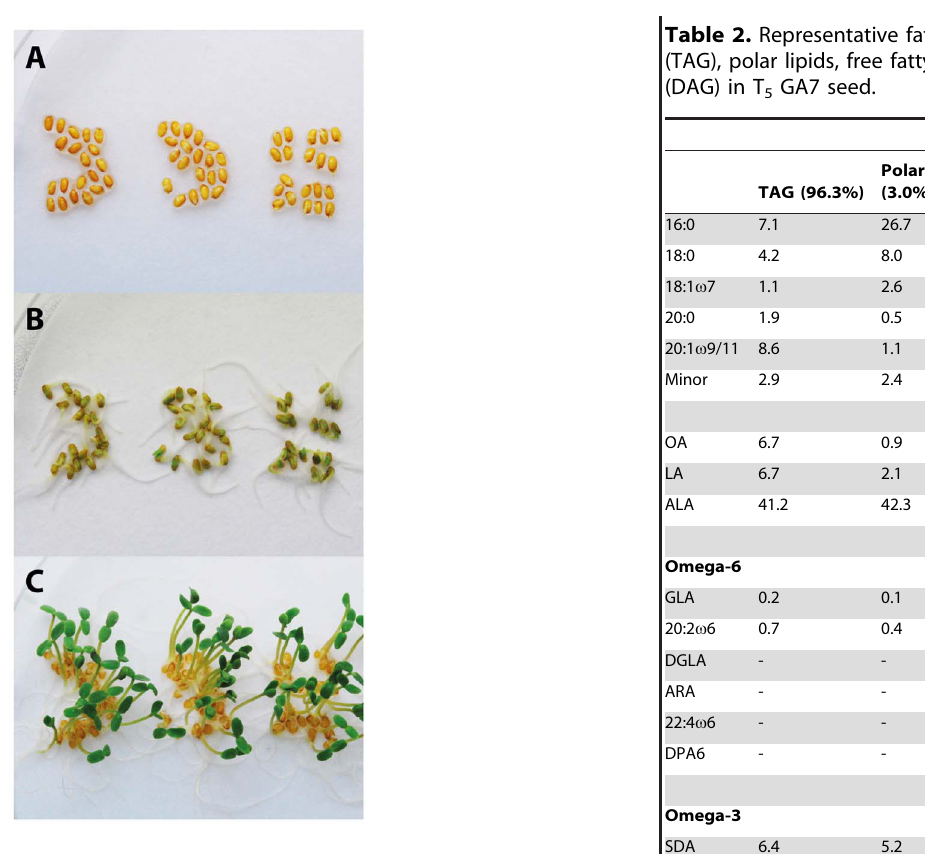
Figure 7. Germination of parental (left) and two transgenic GA7 Camelina sativa T 5 lines (middle and right). A) 0 days following 3 days imbibition in the dark at 4 u C; B) 1 day at 24 u C under light; C) 4 days.